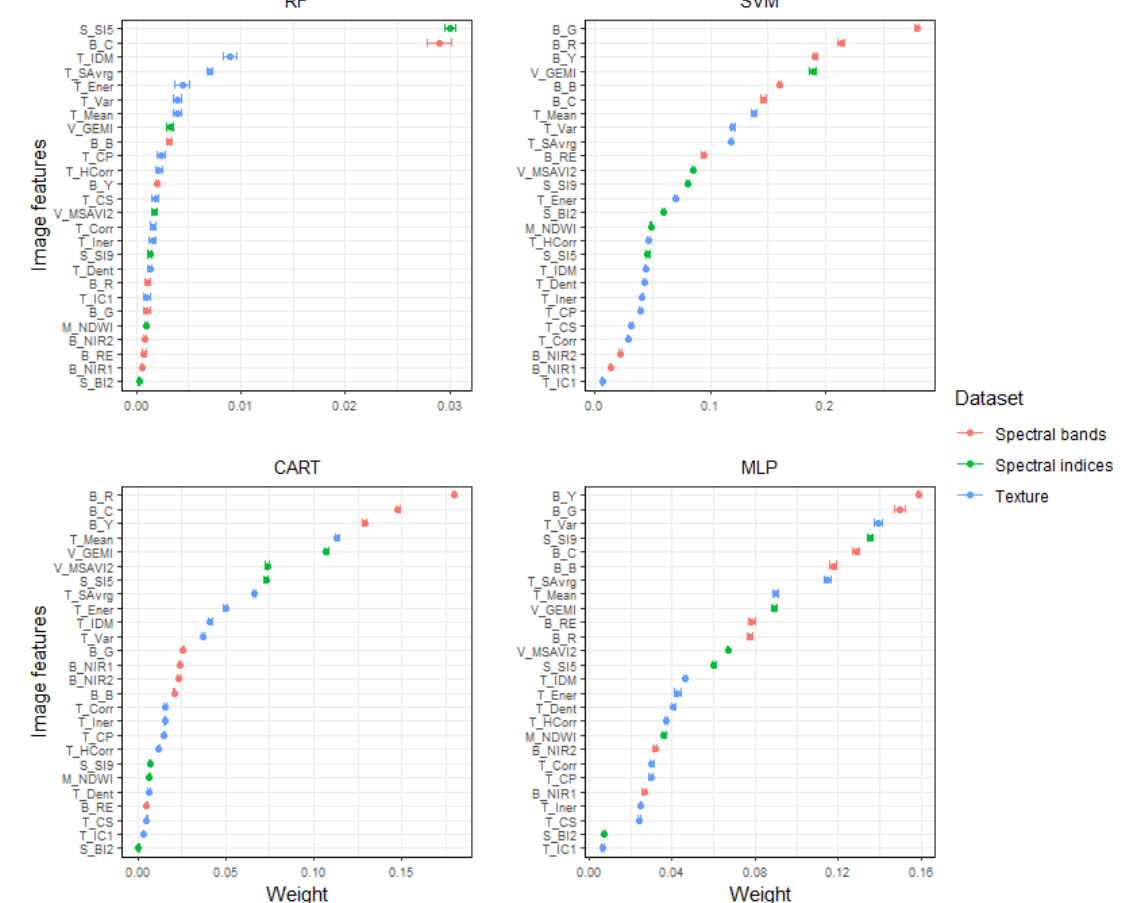
Figure 6. Image feature weights derived from permutation feature importance estimates for Random Forest (RF), Support Vector Machines (SVM), Classification and Regression Trees (CART) and Multilayer Perceptron (MLP) models. Feature weights are sorted in an descending order across models to identify features on high predictive importance. For the detailed names and description of image feature acronyms, refer to Table